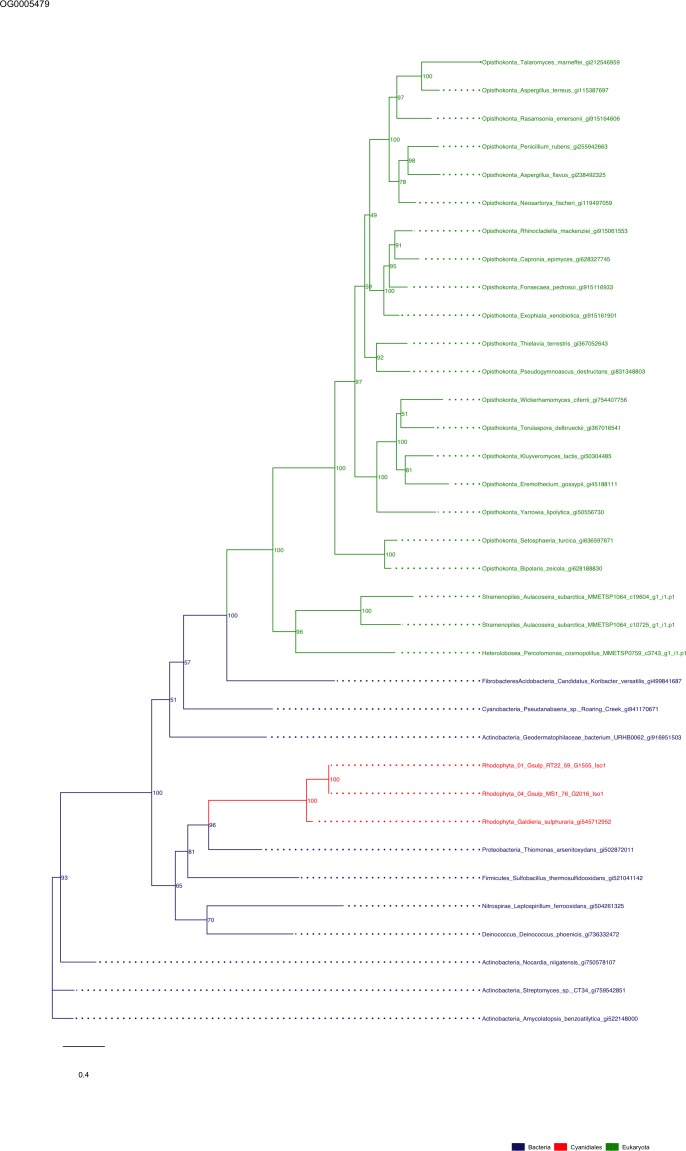
Sequence tree of orthogroup OG0005479.The tree is based on amino acid sequences. Archaea (yellow), Bacteria (blue), Cyanidiales (red), Eukaryotes including other red algae (green). Branches containing Cyanidiales sequences are highlited in red.